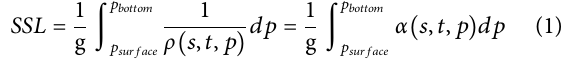
Frontiers in Earth Science |